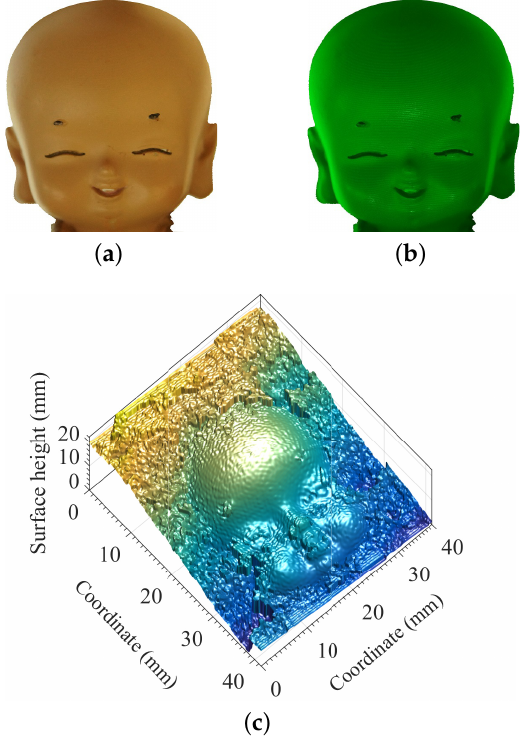
Figure 11. Human-head-model retrieval as background illuminance E = 12,000 Lux for outdoor measurement. ( a ) without filtering; ( b ) with filtering; ( c ) This is the retrieval using the measurement of ( b ), while it is unable to obtain satisfied retrieval using the measurement of ( a